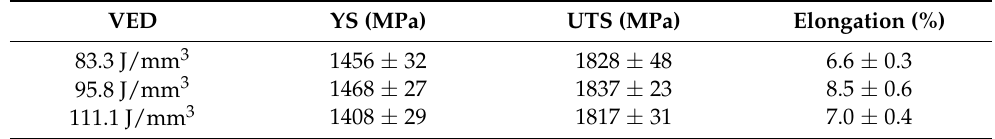
Table 2. Mechanical properties of the SLMed H13 samples under different